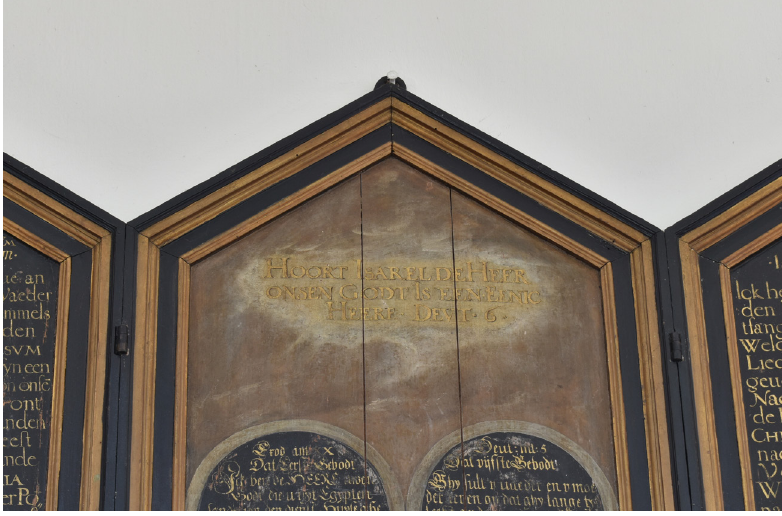
Detail of text triptych in Bourtange, 1611, photo